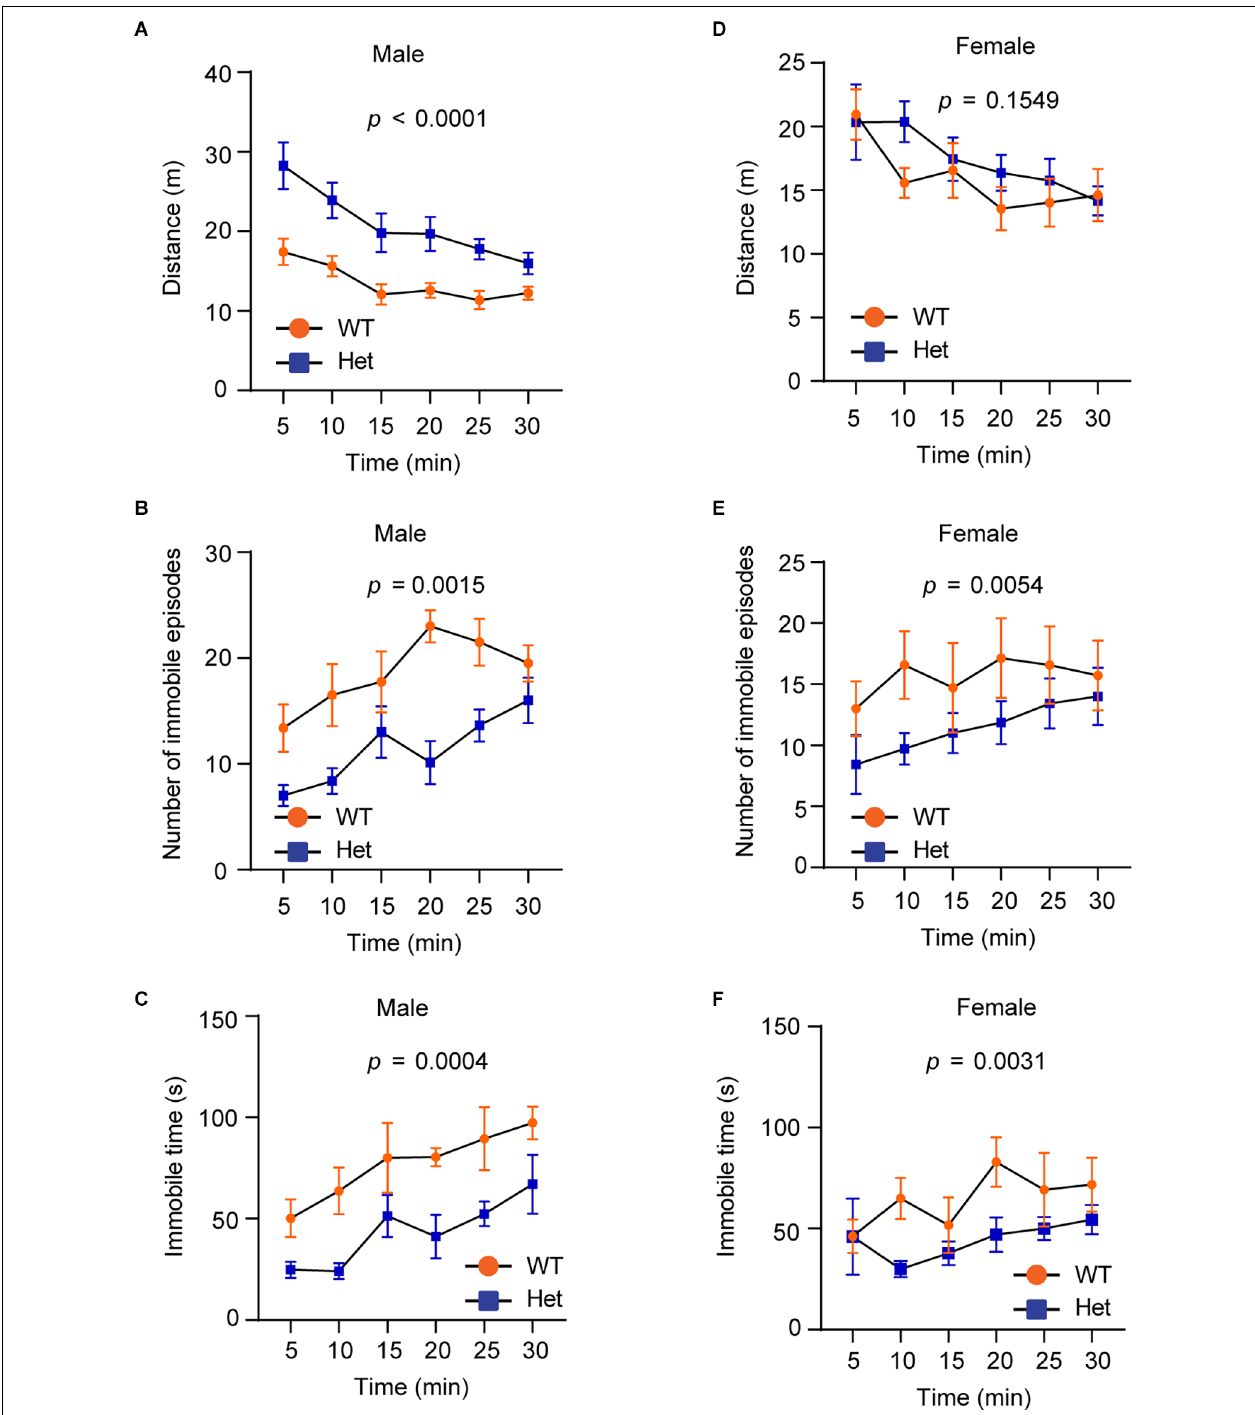
FIGURE 3 | Heterozygous Kdm6b knockout mice display locomotor hyperactivity. (A–C) The plots showing the running distances (A) , immobile episodes (B) , and immobile time (C) of male wild-type and heterozygous Kdm6b -KO mice in a 5-min period for 30 min in the open-field chamber. P-value calculated using two-way ANOVA test. The results shown are the effect of genotype on running distances ( F 1,84 = 53.44, p < 0.0001), the effect of genotype on immobile episodes ( F 1,84 = 36.72, p = 0.0015), and the effect of genotype on immobile time ( F 1,84 = 29.87, p = 0.0004). Error bars in graphs represent mean ± SEM. (D–F) The plots showing the running distances (D) , immobile episodes (E) , and immobile time (F) of female wild-type and heterozygous Kdm6b -KO mice in a 5-min period for 30 min in the open-field chamber. The results shown are the effect of genotype on running distances ( F 1,72 = 2.066, p = 0.1549), the effect of genotype on immobile episodes ( F 1,72 = 8.215, p = 0.0054), and the effect of genotype on immobile time ( F 1,72 = 9.340, p = 0.0031). Error bars in graphs represent mean ± SEM.